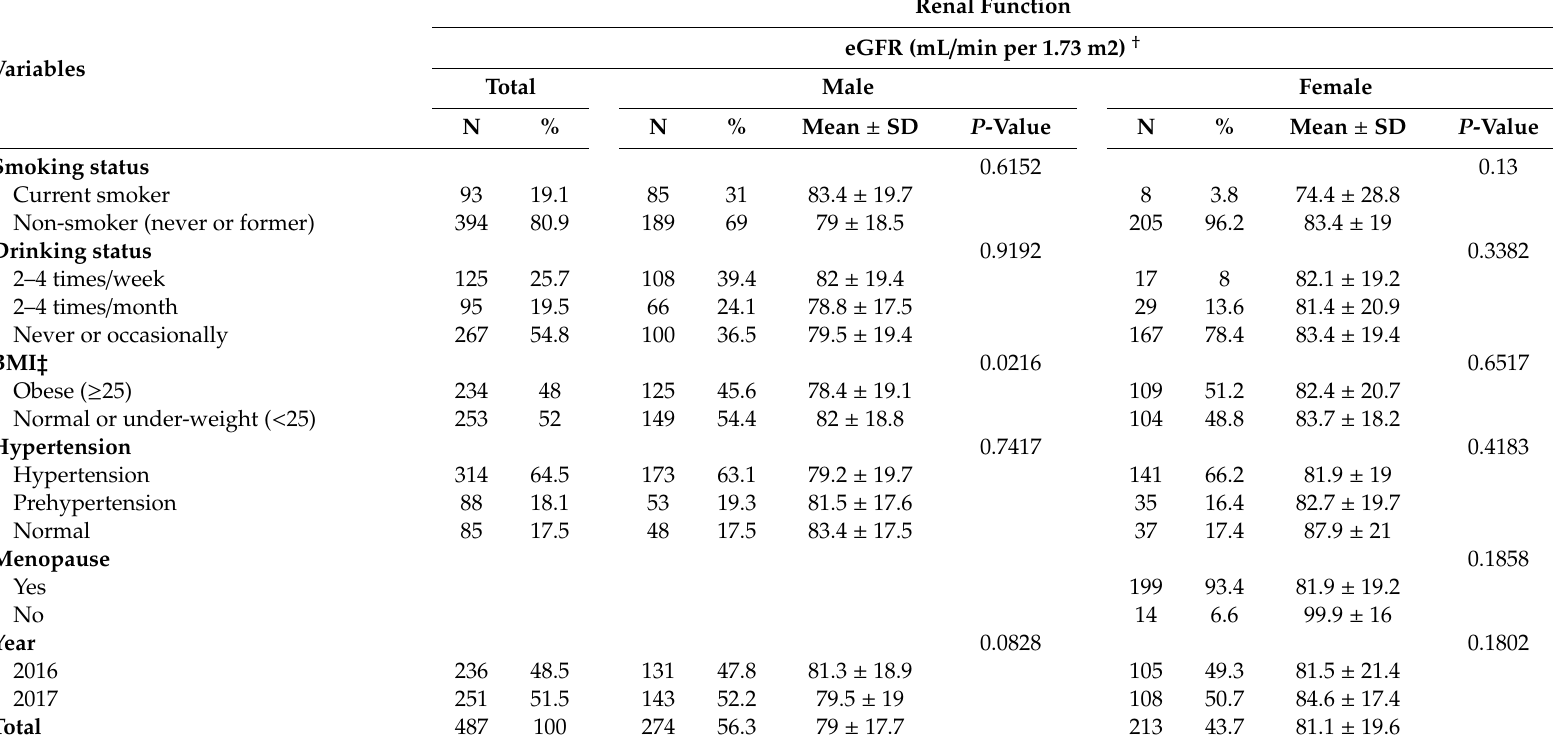
defined by BMI based on 2014 Clinical Practice Guidelines for Overweight and Obesity in